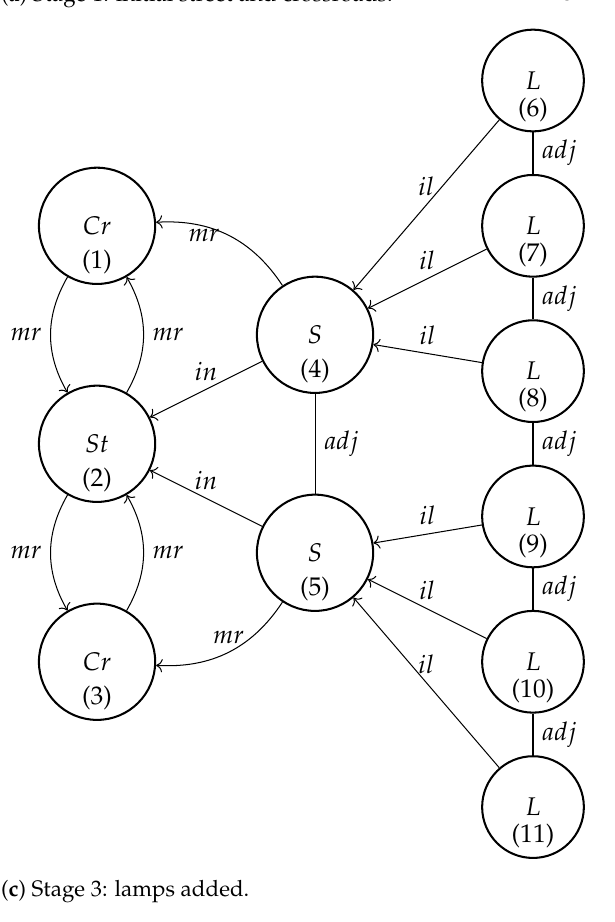
Figure 6. Segment